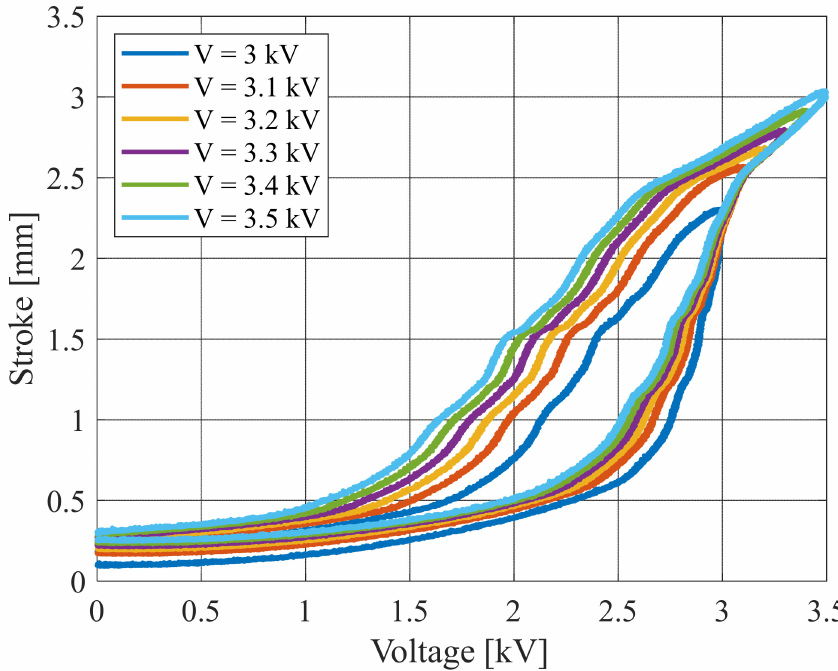
Figure 20. Stroke reached by the DEA as a function of the applied voltage, considering sinusoidal voltage inputs having frequency of 0.1 Hz and different maximum amplitudes.